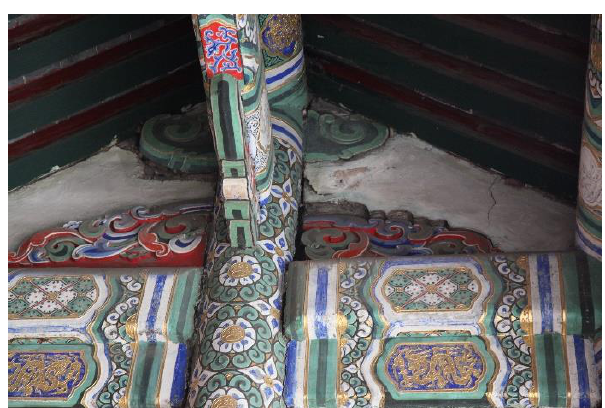
Figure 14 Wooden structure cracks of the temple gate